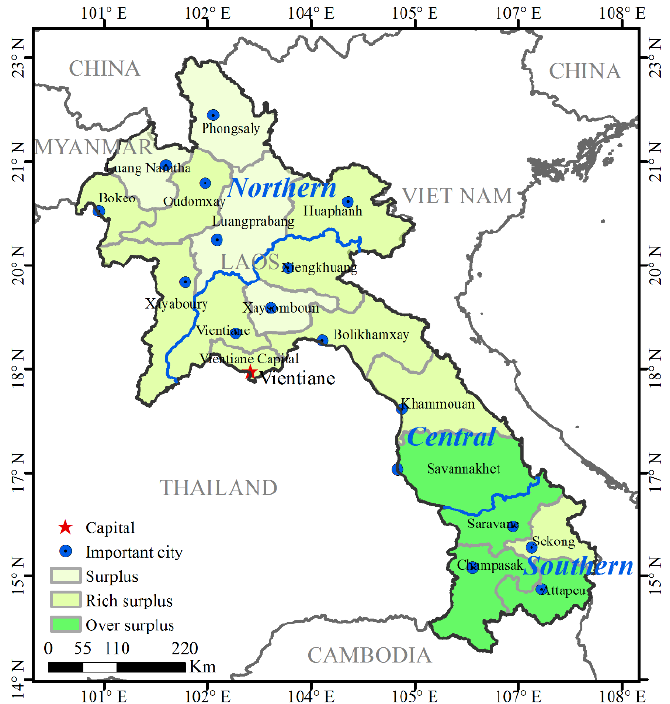
Figure 10. Spatial distribution of resource environment comprehensive carrying status in Laos.